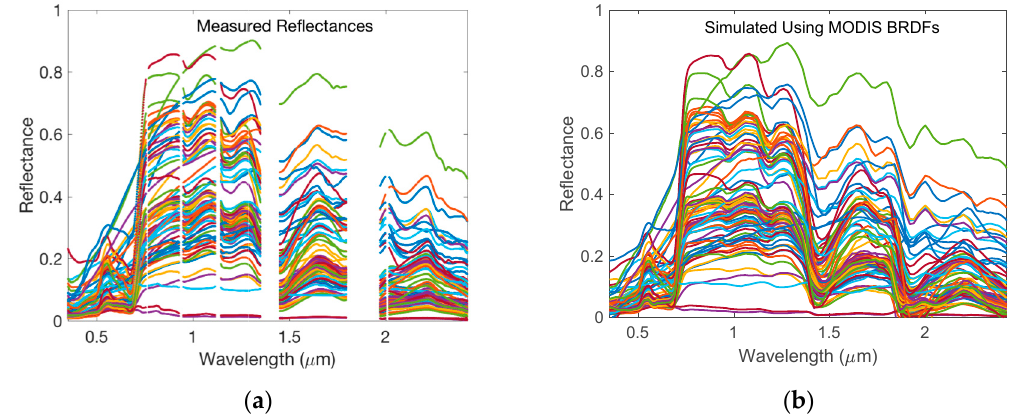
Figure 7. ( a ) The measured reflectances for vegetation from USGS database. The white space areas are wavelength ranges in which the reflectances cannot be measured accurately for some samples; ( b ) The simulated reflectances using HSBR model. The reflectances at MODIS wavelengths used in HSBR model were extracted from the USGS database.